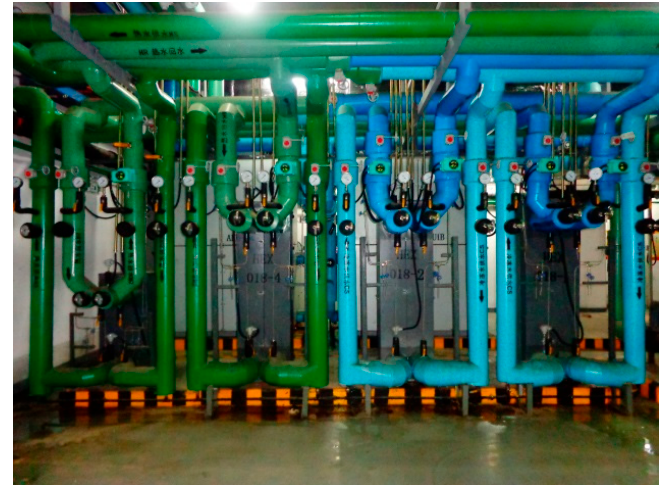
Figure 2. Schematic of the heating system. GSHP: ground-source heat pump; FC: fan coil.